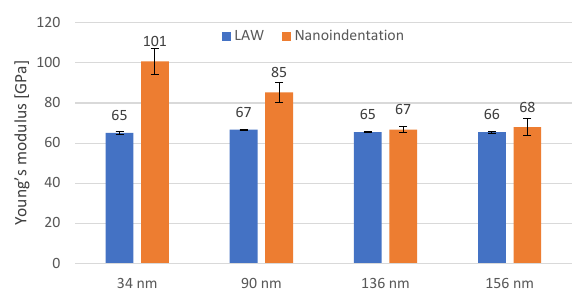
Figure 4. Young’s modulus of SiO different thickness measured by LAW and nanoinden-